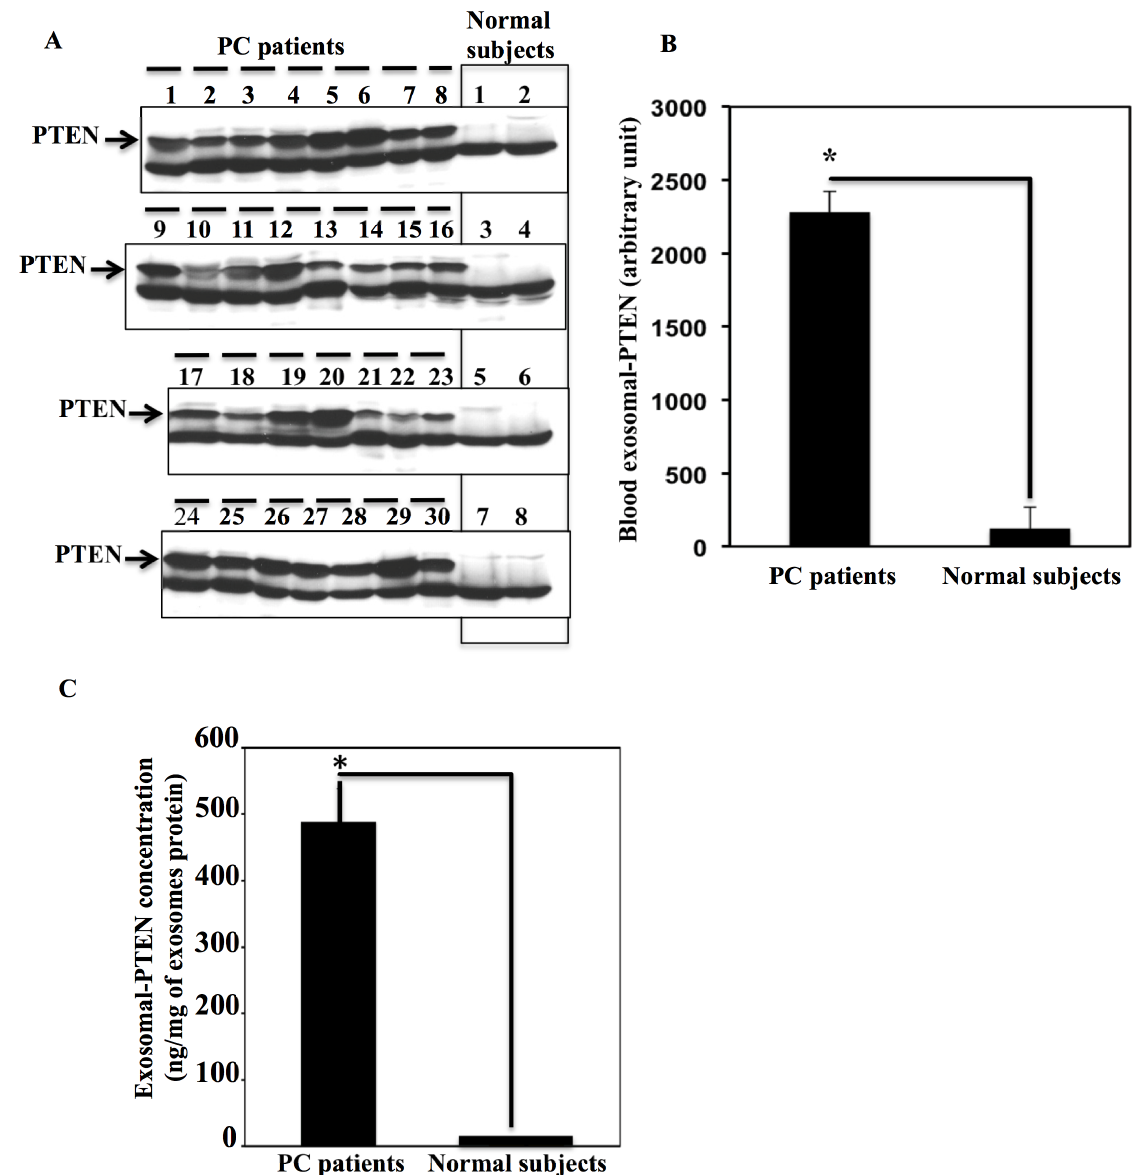
Figure 6. PTEN is detected in exosomes derived from the plasma of PC patients, but not normal subjects. A. Exosomes were collected from the plasma of 30 pre-prostatectomy PC patients and 8 normal subjects. Exosomes were subjected to standard immunoblotting analysis for the status of PTEN. The figure shows the ability of exosomes to assess the status of PTEN. As shown in the figure, the healthy subjects had no PTEN expression in their plasma exosomes. B. Optical densities for PTEN bands (A) were assessed using Quantity-1 software. Exosomal-PTEN expression in PC patients and normal subjects was calculated as the average 6 SEM, and the differences between the two groups were highly significant (P , 0.001). C. PTEN concentration in the exosomes from PC patient blood was assessed by immunoblotting standard concentrations of recombinant PTEN together with the patient samples. The results are the average of PTEN expression 6 SEM and are statistically significant P , 0.01.